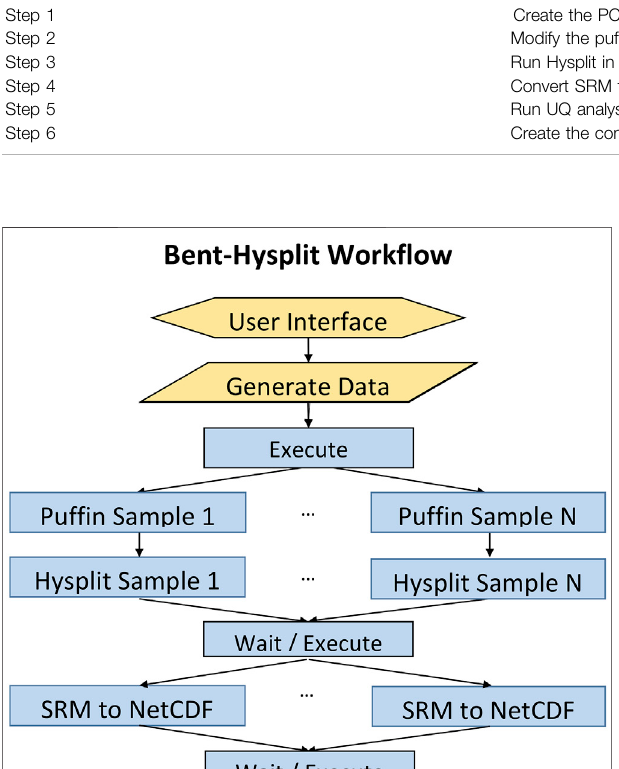
TABLE 2 | Bent hysplit work fl ow parallelization strategy. Step 1 Create the PCQ/CUT sample points. Step 2